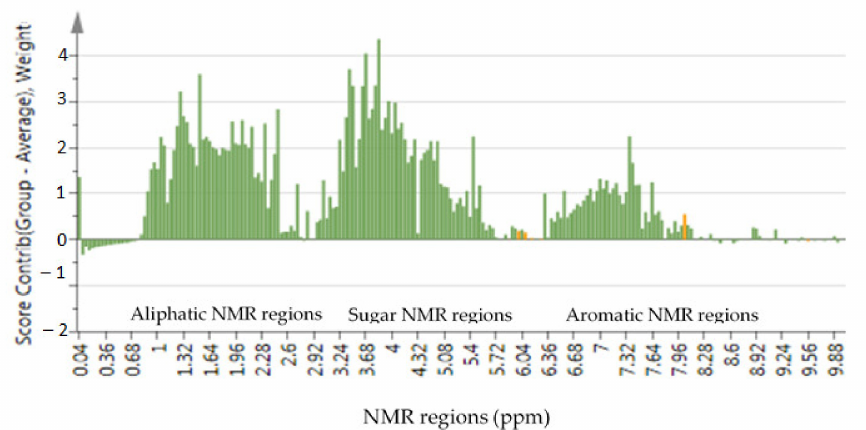
Figure 4. Contribution plot showing metabolites peaks in the NMR aliphatic, sugar, and aromatic regions of M. oleifera leaf metabolomics associated with low and intermediate harvesting frequencies clustering (red circled) (Figure 2). Above line, NMR regions were positively associated/contributed to the